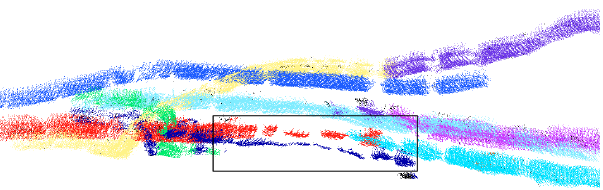
Figure 6: Example of trajectory recovery by points that are par- tially scanned on objects (highlighted in the black rectangle). Three basic types of errors/values are determined for the esti- mated tracks against the ground